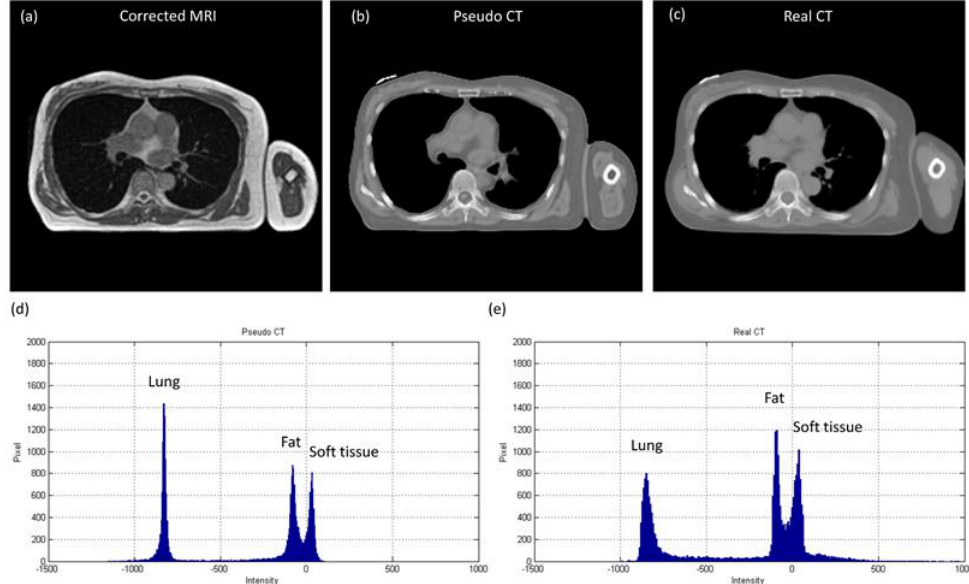
Figure 7. ( a ) Corrected MRI from 0.35 T scanner (WL/WW = 100/200), ( b ) pseudo-CT (WL/WW = 0/1000), ( c ) real CT (WL/WW = 0/1000), ( d ) histogram of pseudo-CT, and ( e ) histogram of real CT for chest imaging used to generate CNN validation dataset ( IMG validationchest ).